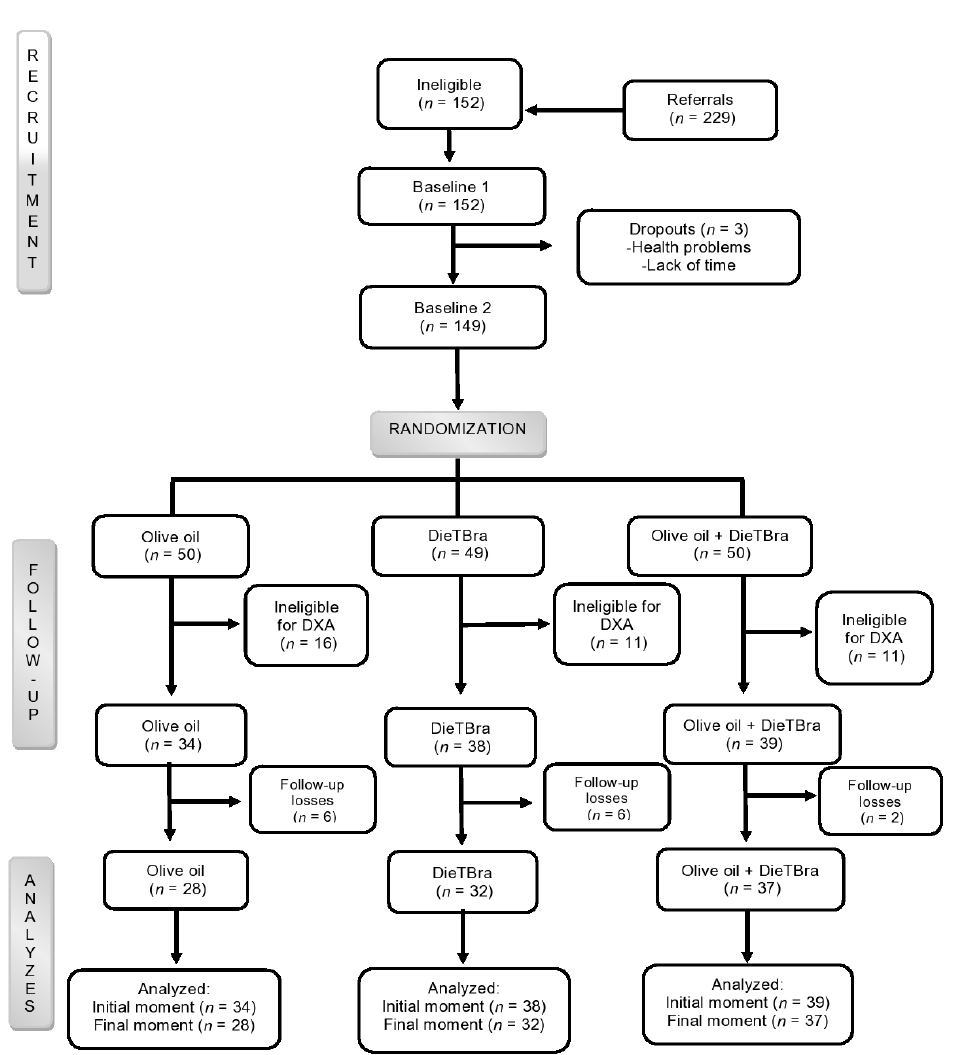
Figure 1. Flowchart of the severely obese participants in the study.